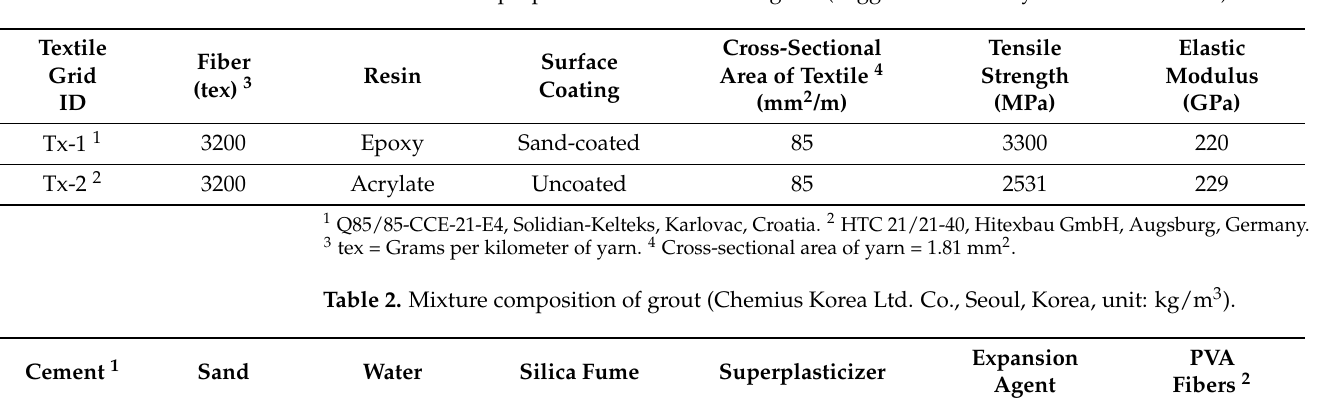
Table 1. Material properties of carbon textile grids (suggested values by the manufacturers).